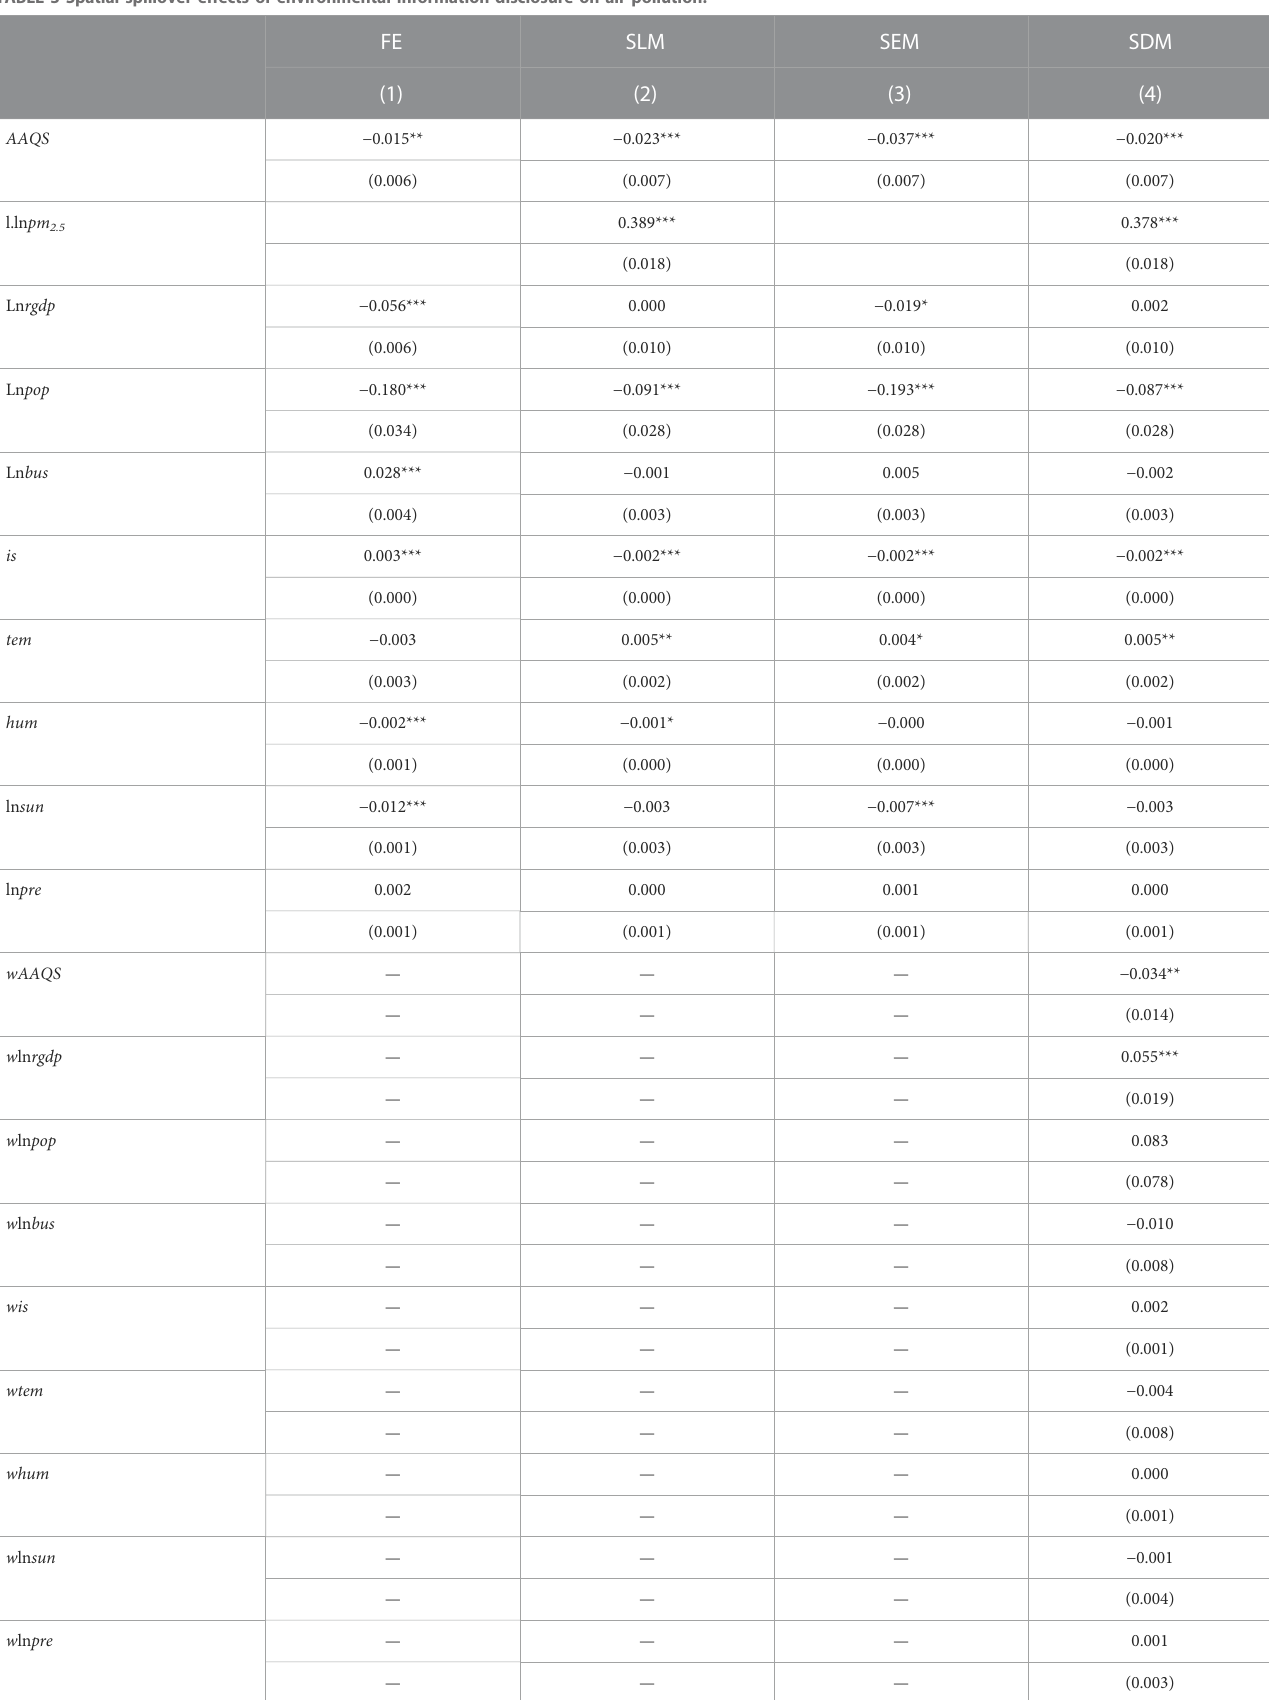
TABLE 3 Spatial spillover effects of environmental information disclosure on air